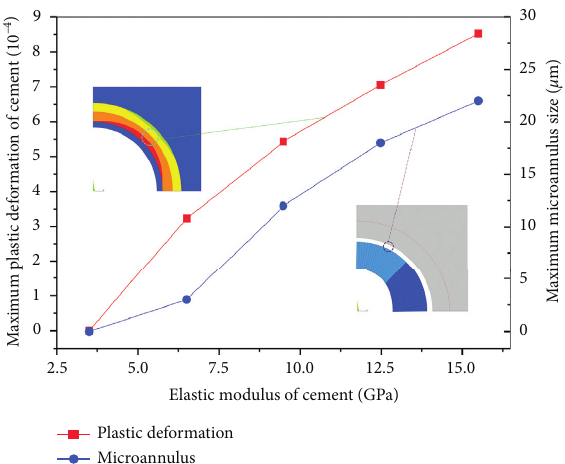
Figure 10: Influence of the elastic modulus of the cement on microannulus size.